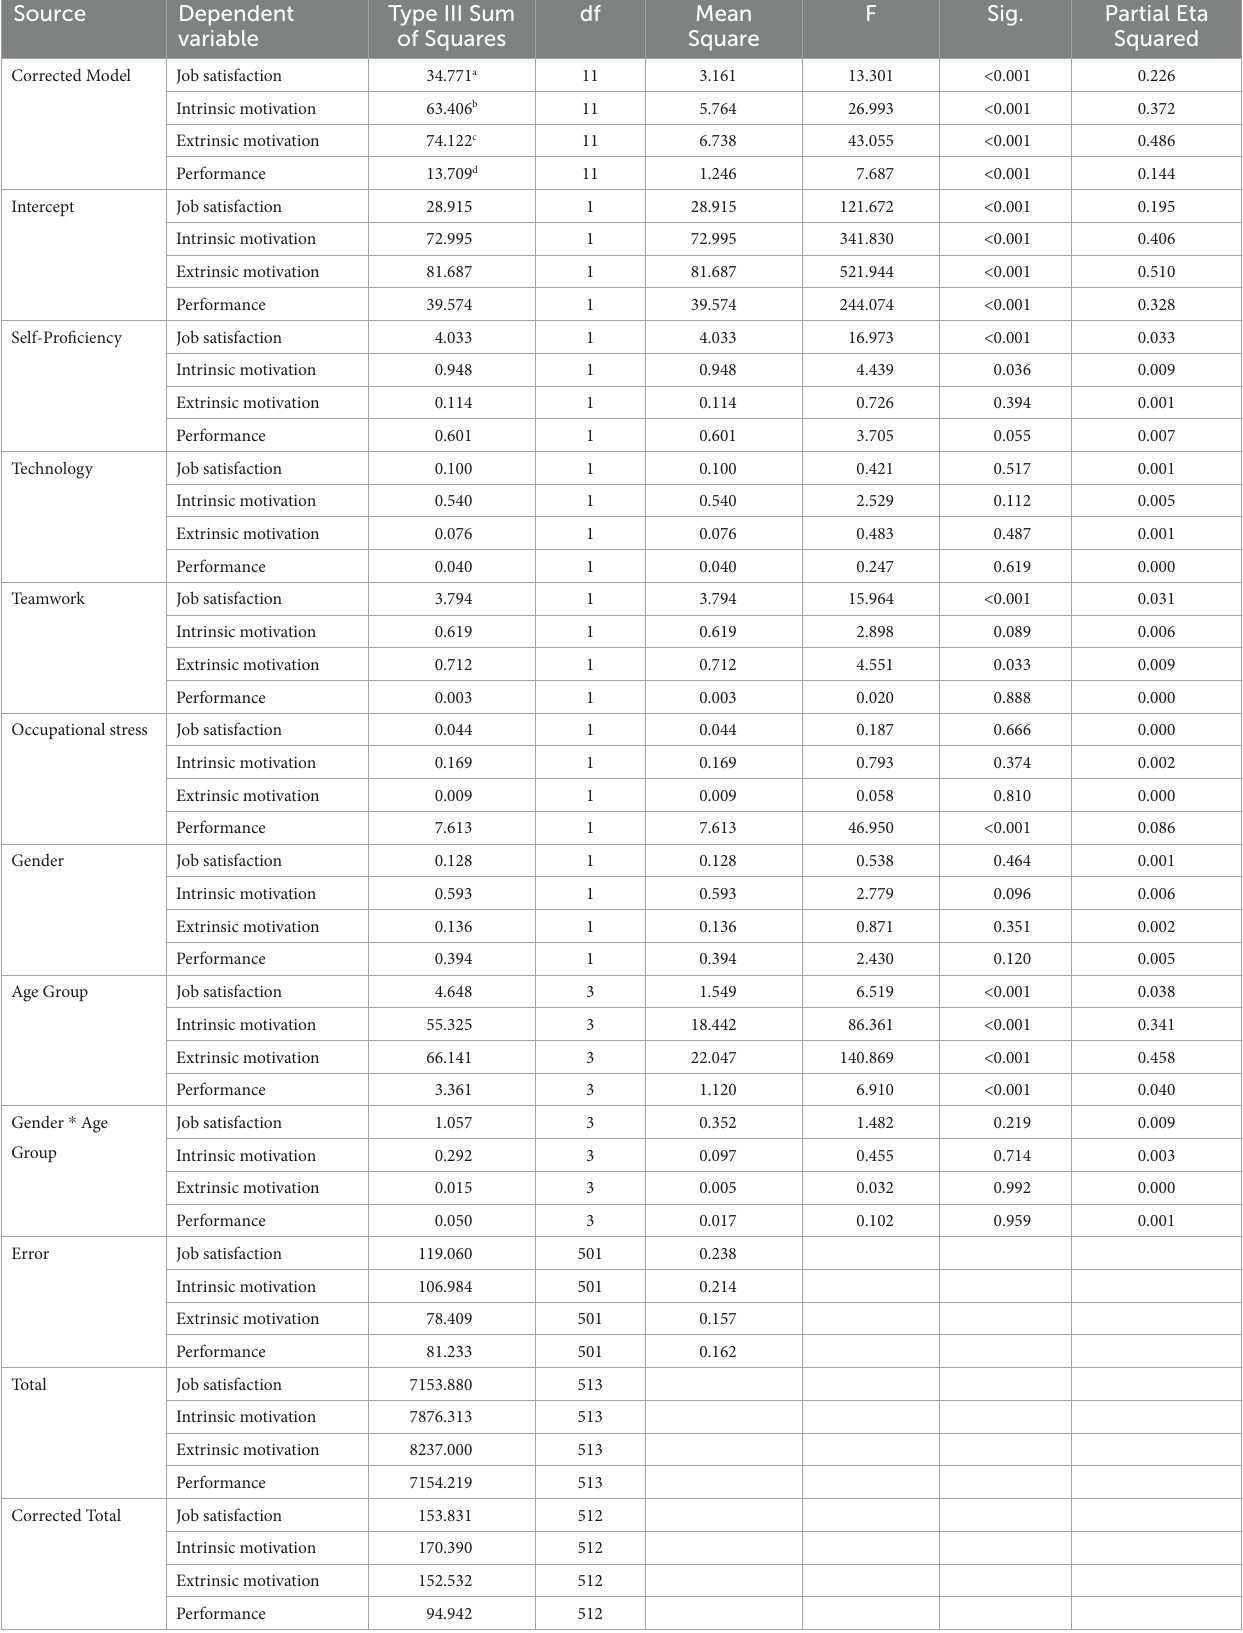
TABLE 9 General linear model multivariate analysis: Tests for between-subjects